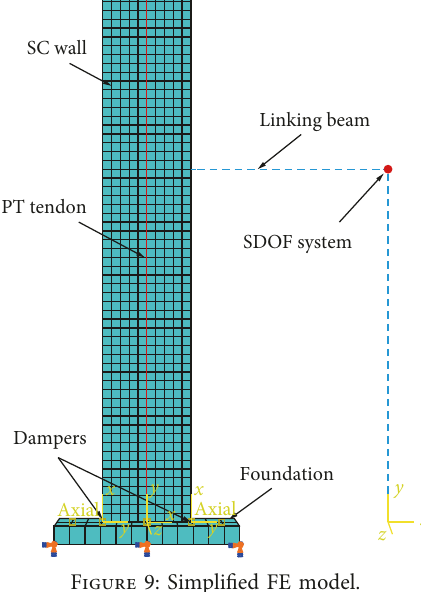
Figure 9: Simplified FE model.